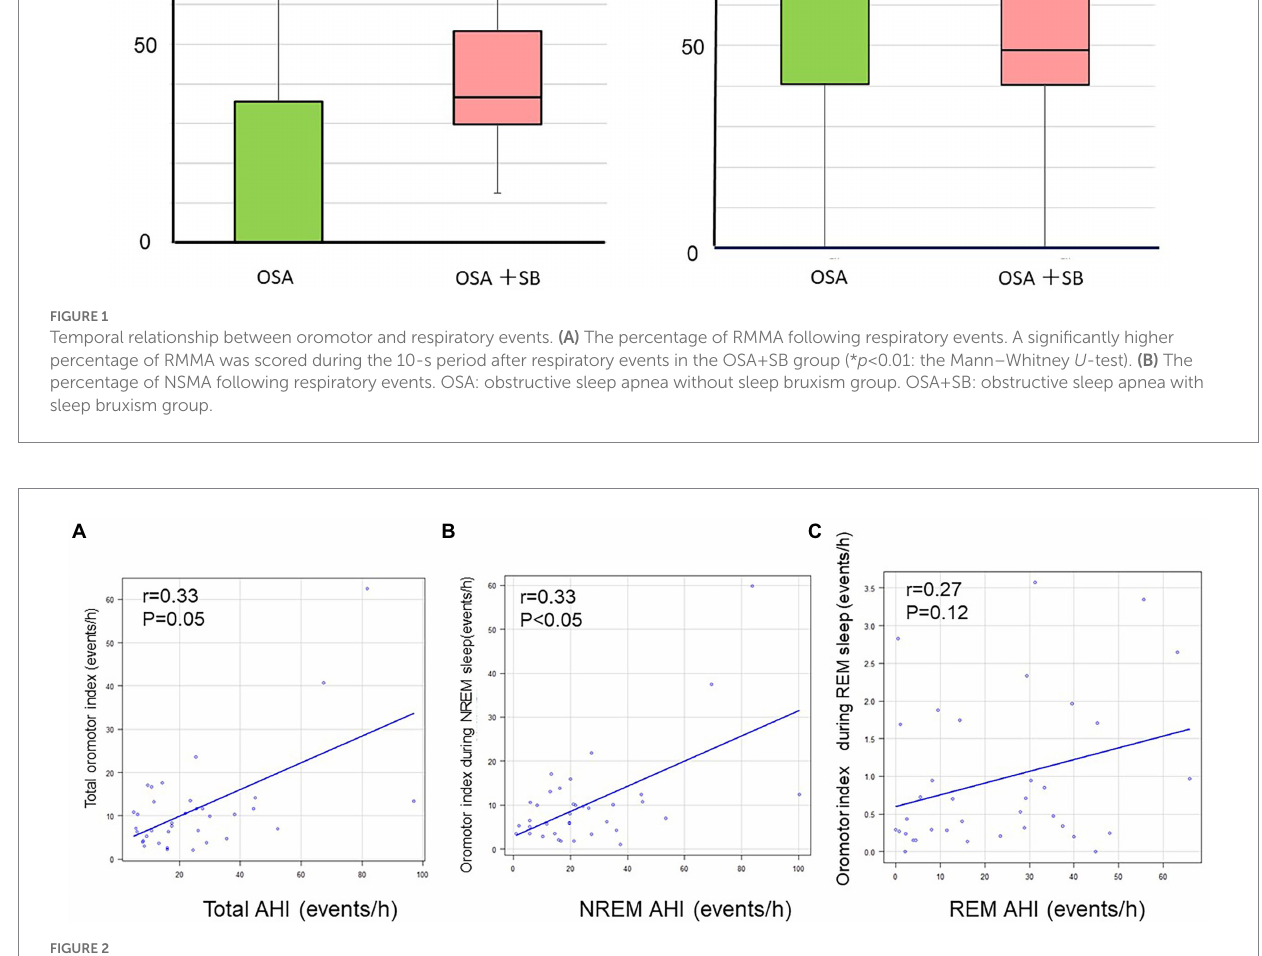
FIGURE 2 Relationships between AHI and the oromotor index. (A) Relationship between AHI and the oromotor index for the whole night. (B) Relationship between AHI and the oromotor index during NREM sleep. (C) Relationship between AHI and the oromotor index during REM sleep. The frequency of oromotor events positively correlated with that of apnea/hypopnea for the whole night and during NREM sleep (Spearman’s correlation coefficient). AHI: apnea-hypopnea